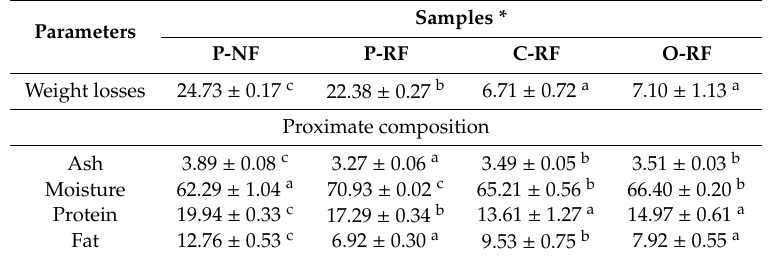
* For samples denominations, see Figure 1. Means ± standard deviation. Di ff erent superscript letters ( a,b,c ) in the same row (for each parameter) indicate significant di ff erences ( p < 0.05) between di ff erent formulations (P-NF, P-RF, C-RF and